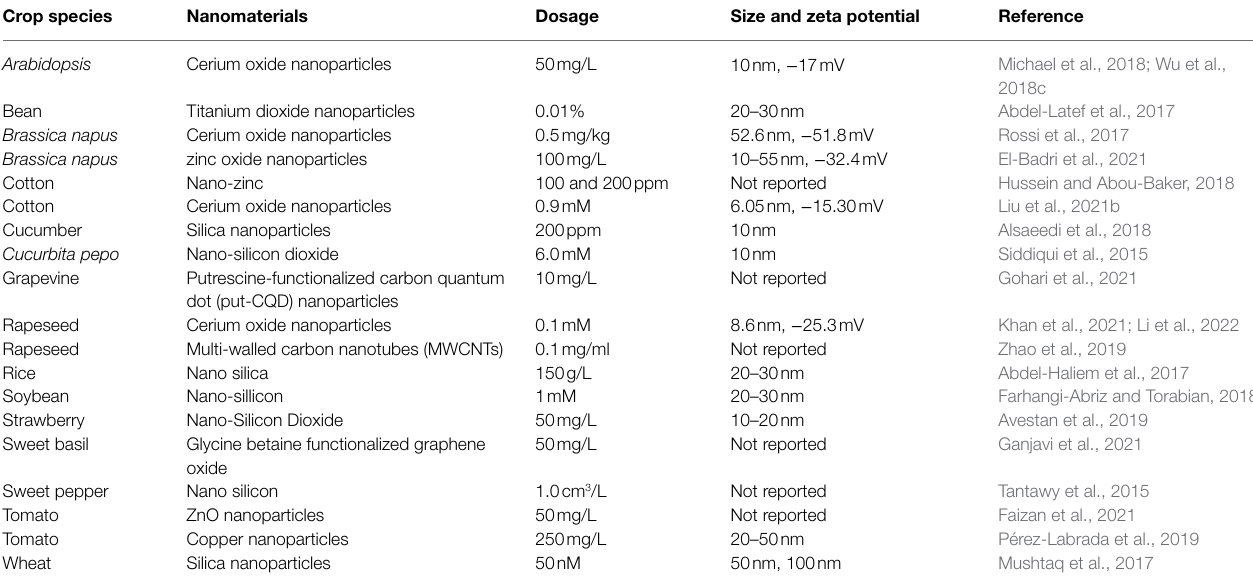
TABLE 1 | The known nanomaterials used for improving plant salt